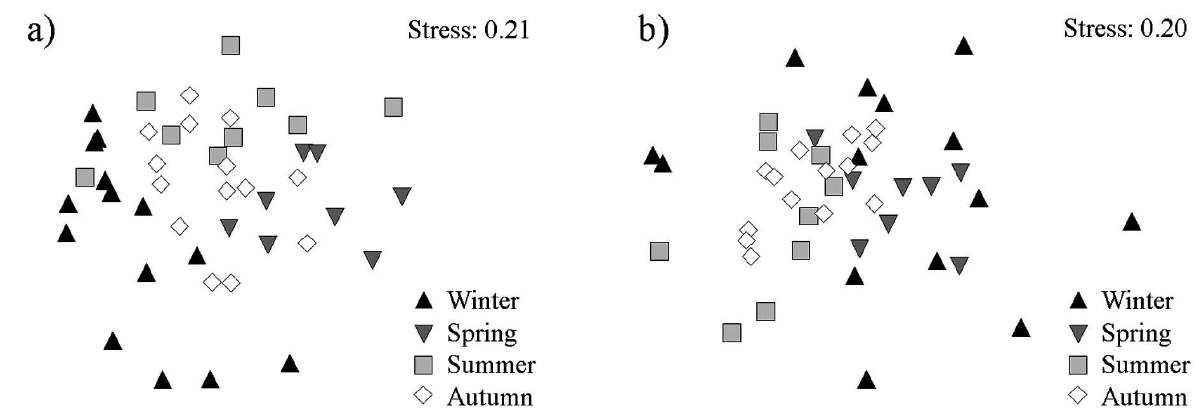
Fig . 4. – MDS ordination showing retained catch composition (a) and discard composition (b) based on numbers of individuals caught in the four different seasons.